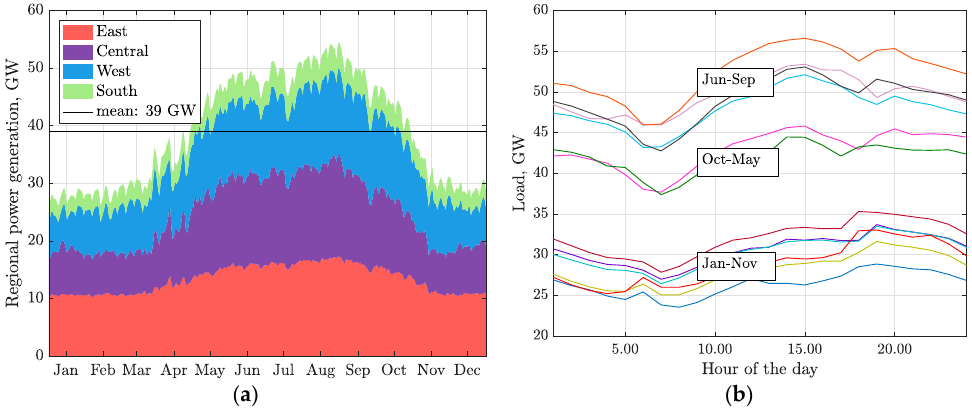
Figure 10. ( a ) Average daily power generation (load) in each operation region ( b ) Daily power generation (load) curve averaged for each month. Source: Authors based on 2015 data from Saudi Electricity Company (SEC) Note: Does not include transmission and distribution losses.